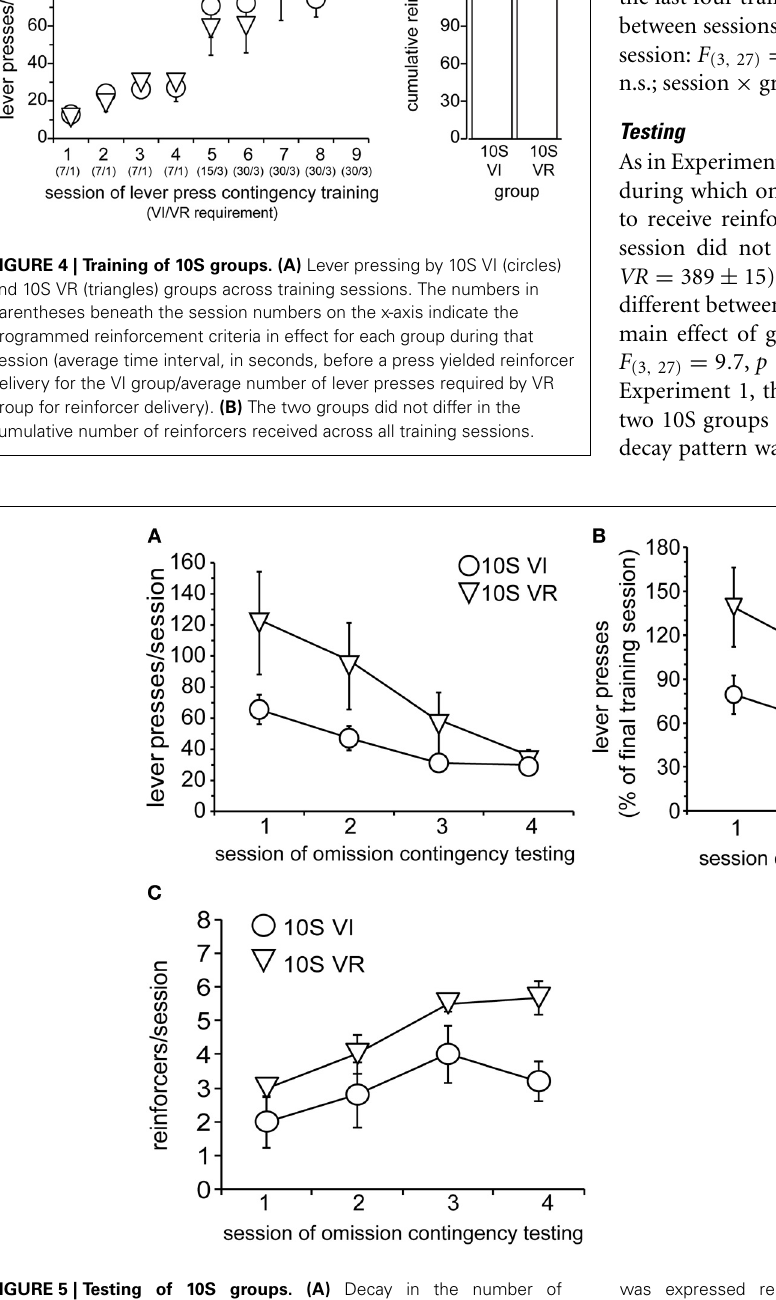
was expressed relative to training performance. (C) The number of reinforcers received per session increased similarly for the two groups across testing, but the 10S VR group received more reinforcers